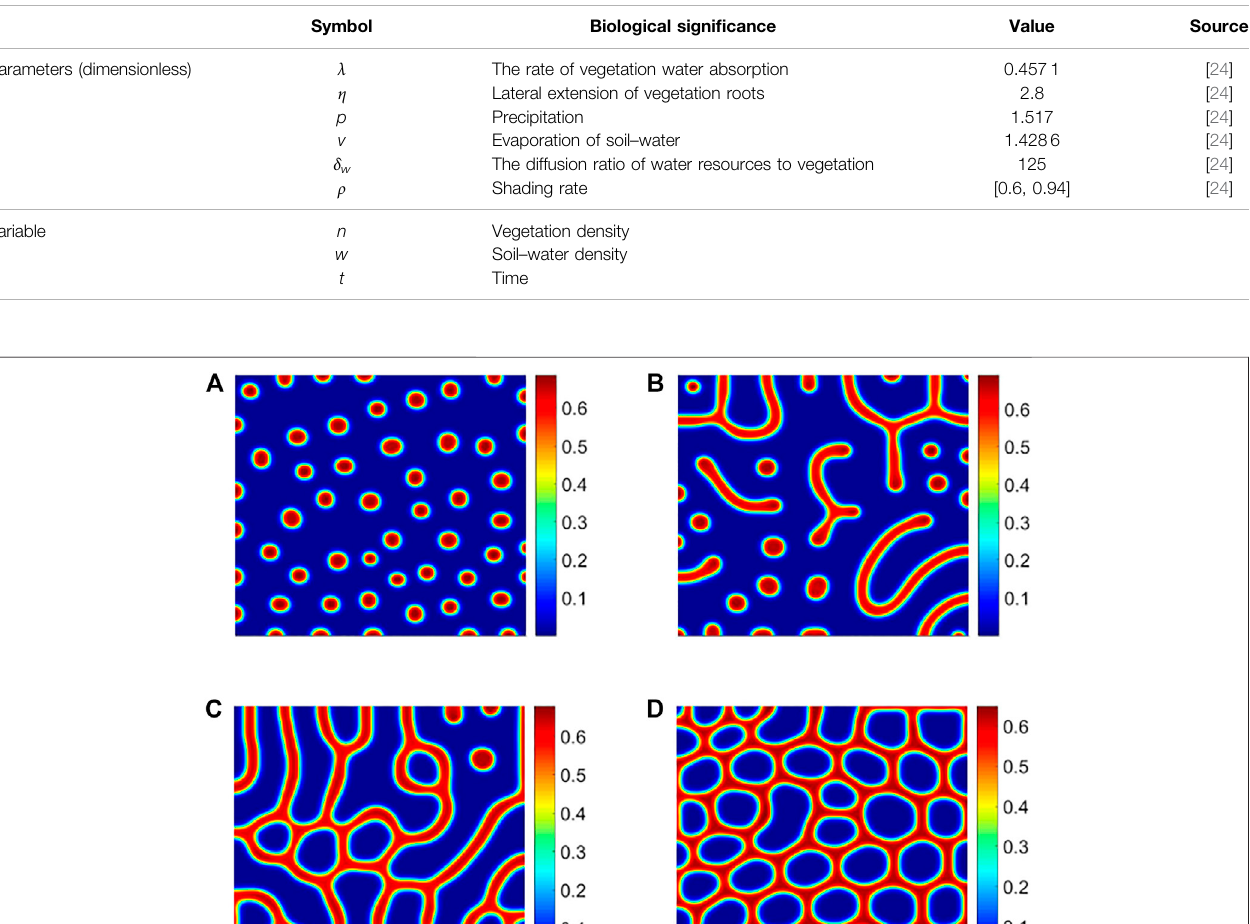
TABLE 1 | Biological signi fi cance and value of all parameters in the model (2).